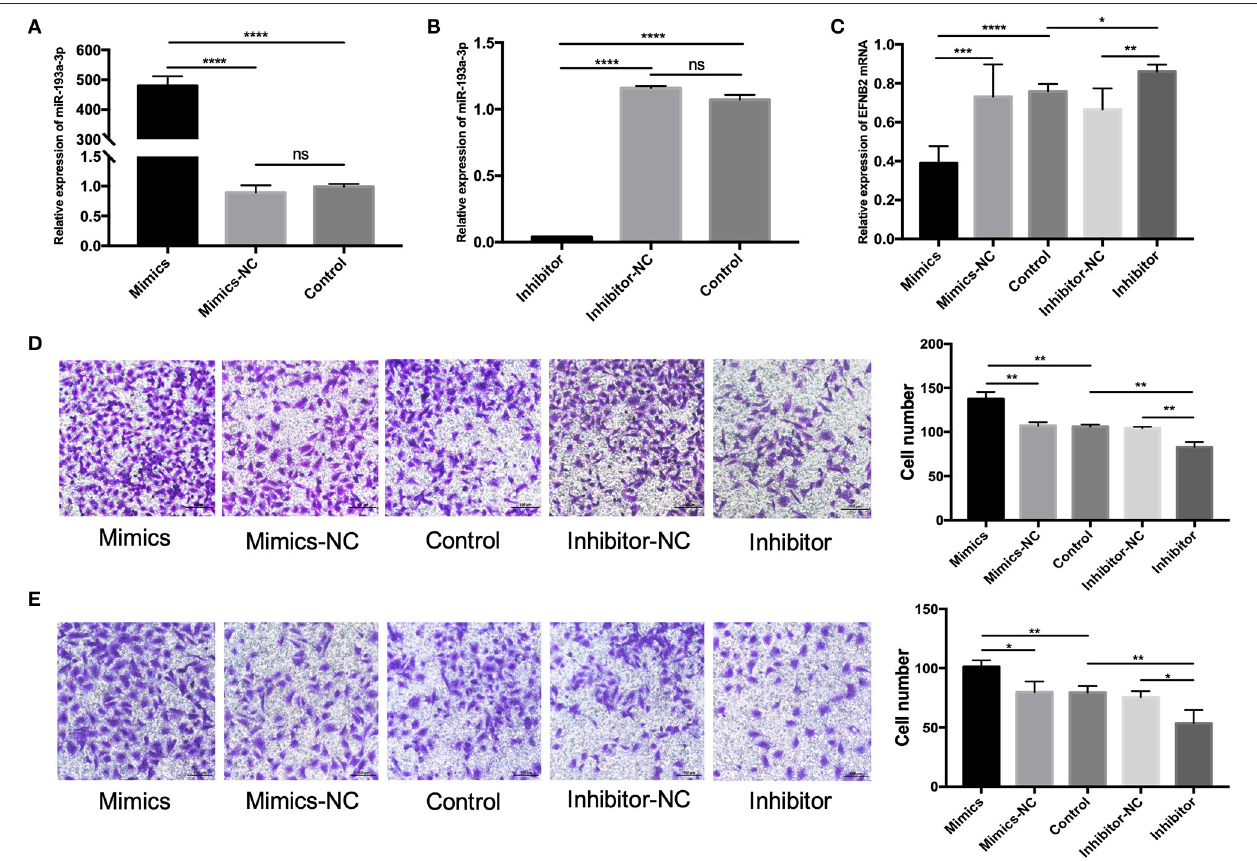
FIGURE 2 | miR-193a-3p promotes the migration and invasion of HTR-8/SVneo cells. (A,B) The level of miR-193a-3p increased and decreased after 48-h transfection of HTR-8/SVneo cells with miR-193-3p mimics or miR-193a-3p-inhibitor. (C) EFNB2 mRNA expression observed after 48-h transfection with miR-193a-3p-inhibitor or miR-193-3p mimics to demonstrate the relationship between miR-193a-3p and EFNB2. (D) Transwell migration assay showing significantly more migrated cells in the mimics group than in the NC group, whereas the migrated cells in the inhibitor group showed the opposite trend ( × 200). (E) Transwell invasion assay revealed more invaded cells in the mimics group than in the NC group, whereas the invaded cells in the inhibitor group showed the opposite trend ( × 200). All data are presented as the mean ± standard deviation. EFNB2, Ephrin-B2; miR, microRNA; mimics, miR-193a-3p mimics; inhibitor, miR-193a-3p inhibitor; NC, negative control. * P < 0.05, ** P < 0.01, *** P < 0.001, and **** P <